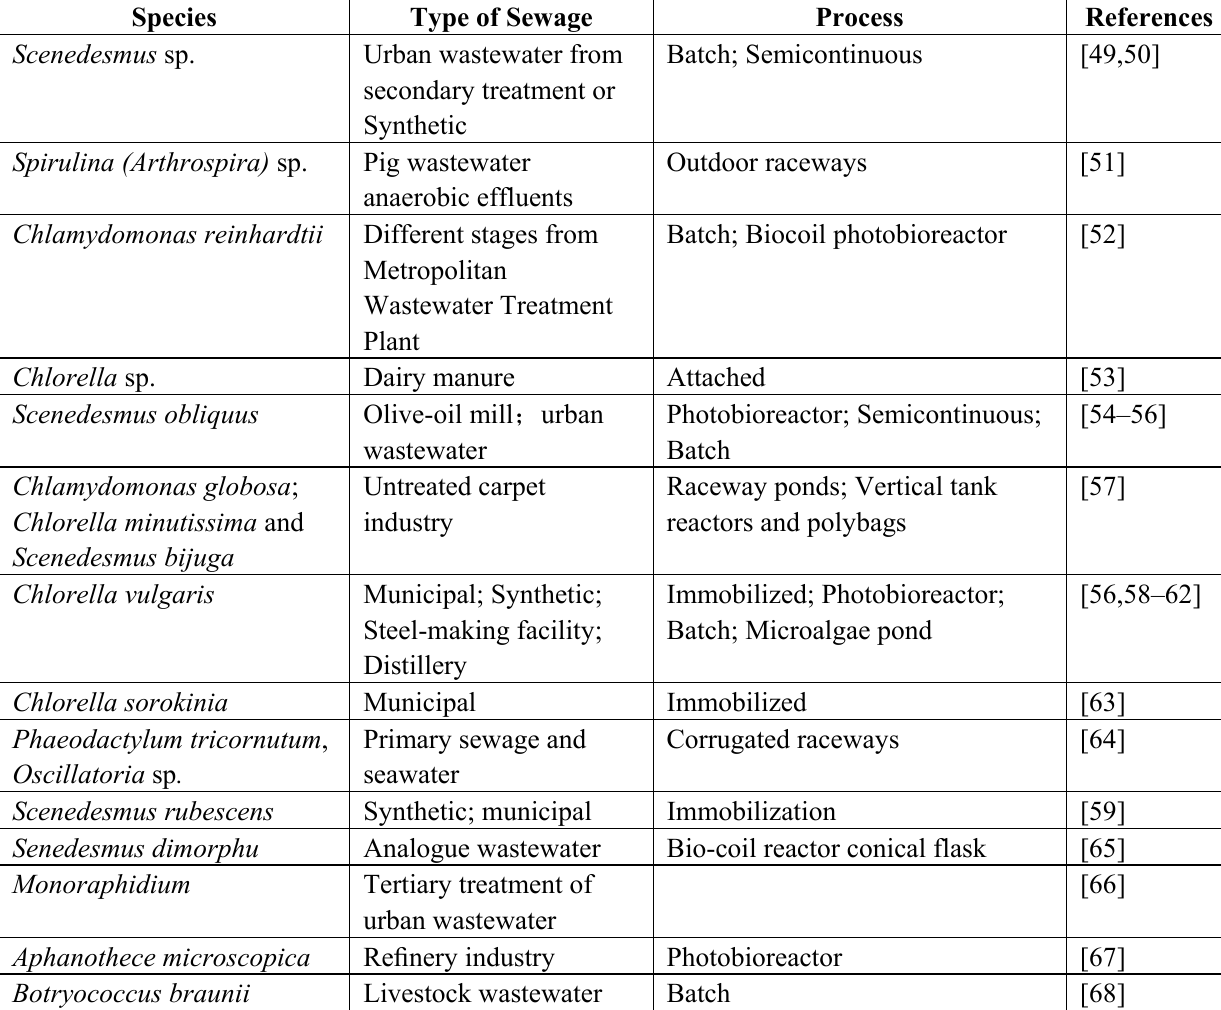
Table 6. Typical strains cultivated in